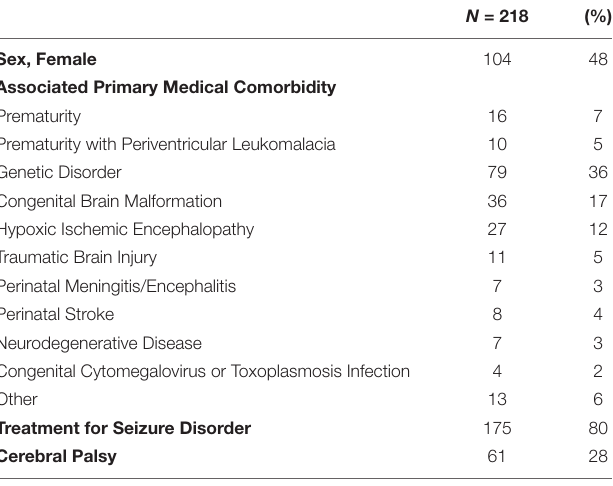
TABLE 1 | Clinical characteristics of cerebral visual impairment (CVI) cohort.